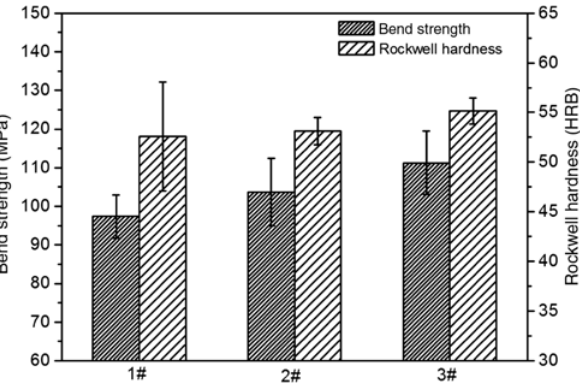
Figure 7: The bend strength and hardness of diamond/epoxy com- posites (i) 1#: sample with pristine diamond; (ii) 2#: sample with KH550 modified diamond in aqueous alcohol; and (iii) 3#: sample with KH550 modified diamond in